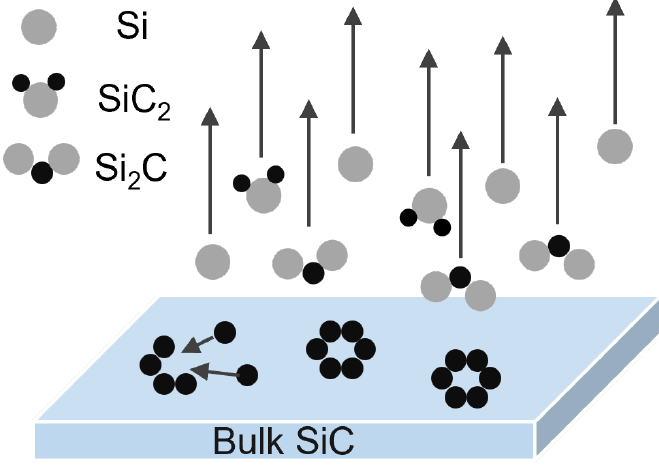
Figure 1. Graphene formation on SiC. During the thermal decomposition process, Si atoms and particles containing Si atom escape from the SiC substrate surface. Residual C atoms on the substrate surface tend to form a honeycomb lattice. Blue-grey bulk is SiC substrate. The Grey and black solid circles are Si atoms and C atoms, respectively.